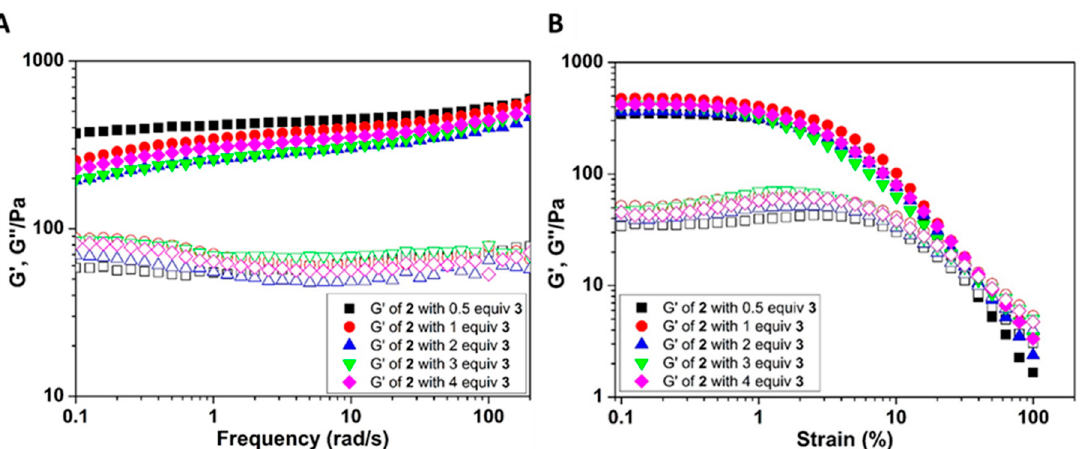
Figure 4. ( A ) Frequency dependence of the dynamic storage moduli (G’) and the loss moduli (G”) of 0.4 wt% NapFFKKFK-